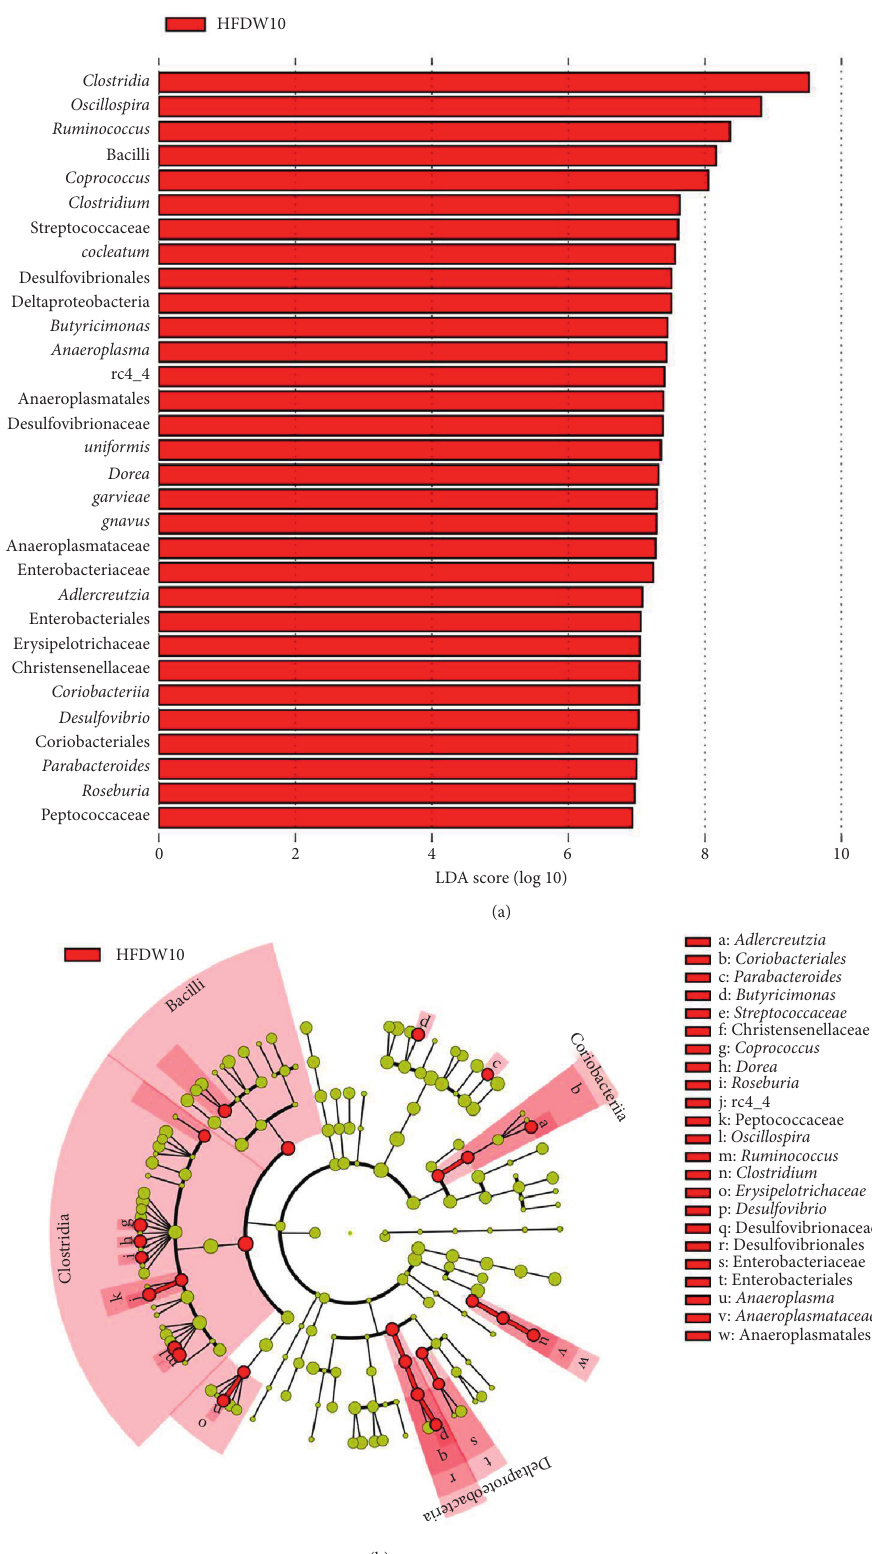
Figure 6: Change in differently abundant taxa between fecal samples of HFD rats collected at week 0 and week 10. (a) Linear discriminate analysis of effect size (LEfSe) results depicting different microbial taxonomic signatures in fecal samples collected from male Sprague- Dawley rats fed HFD ( n � 5-6/group) at week 10 in comparison to HFD week 0 samples. Fecal samples collected from HFD-fed rats at week 10 were more abundant in bacteria in the following phyla: Firmicutes, Proteobacteria, Bacteroidetes, Tenericutes, and Actinobacteria. No other differences were detected. (b) Cladogram depicting differentially abundant microbial taxa in stool samples collected from male Sprague-Dawley rats fed HFD ( n � 5-6/group) for 10 weeks. Microbial taxa enriched in HFD rats are shown in